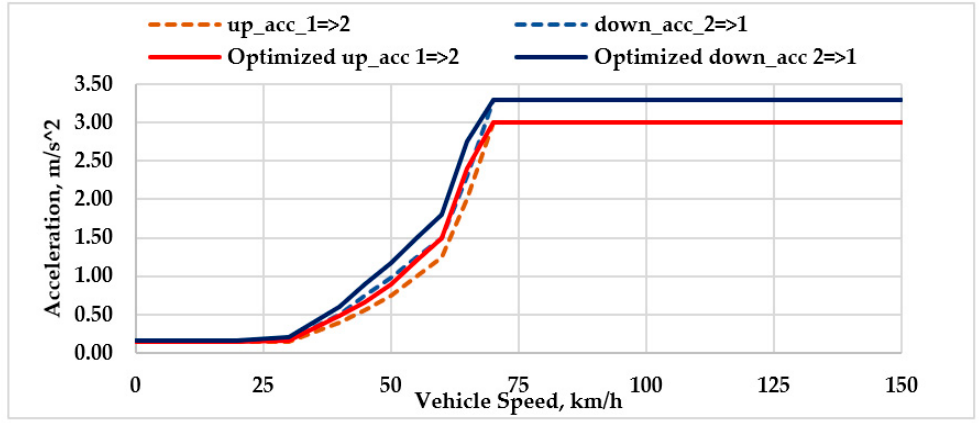
Figure 12. Gearshift schedule in relation to vehicle acceleration before and after optimization.